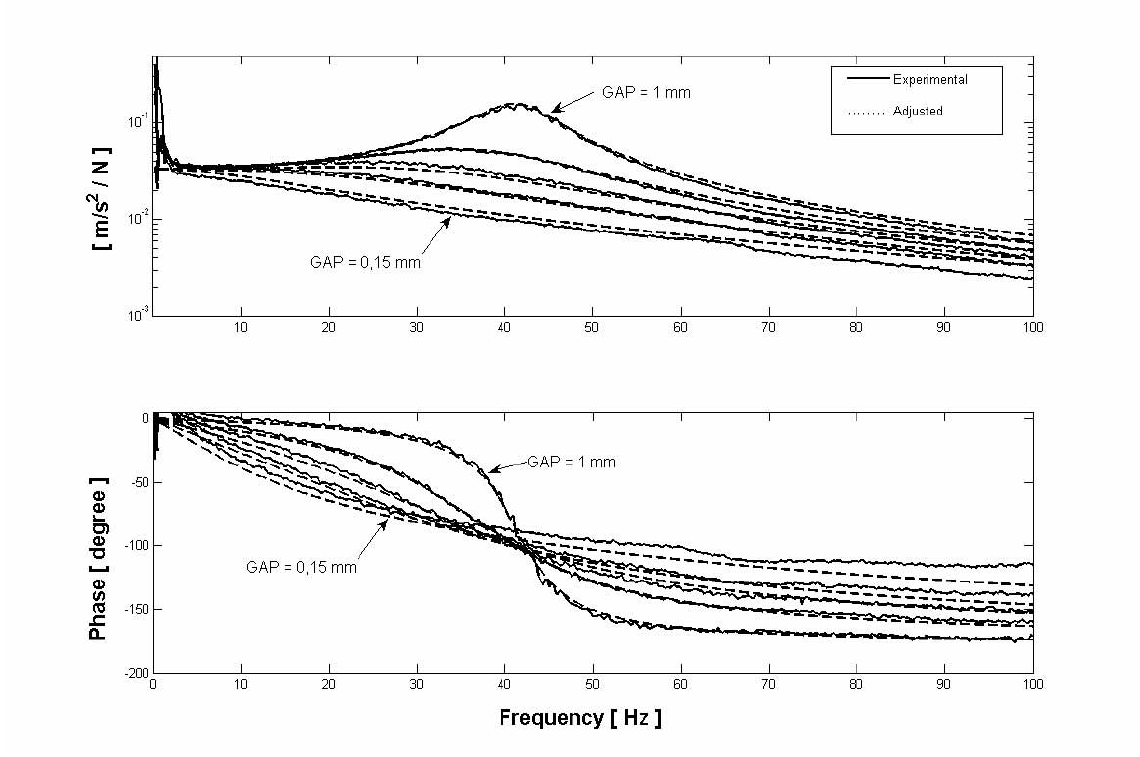
Fig. 11. Experimental and estimated FRF for different GAP